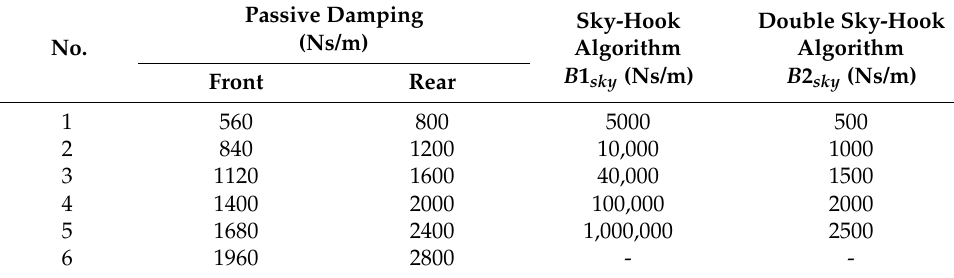
Table 3. Damping